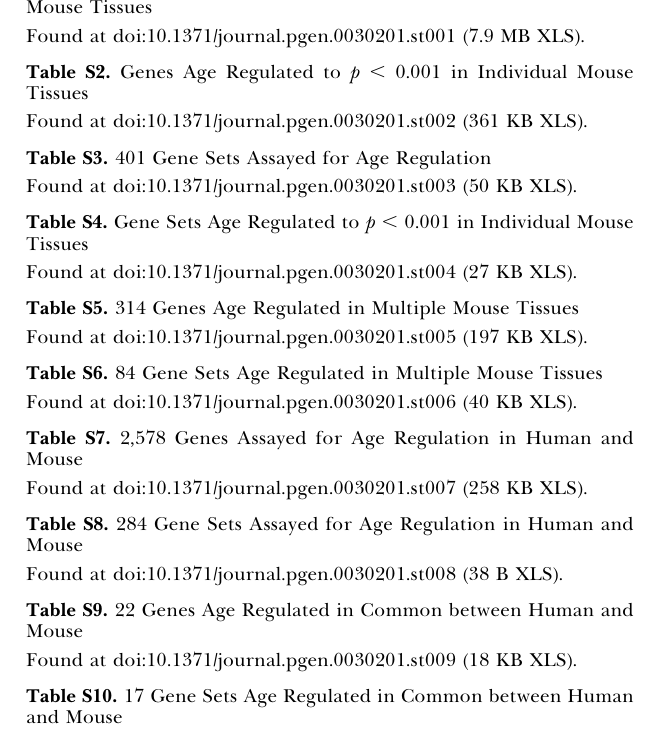
Figure S1. No Overall Correlation of Age-Regulated Expression Changes between Mouse and Human in Kidney and Muscle (A) Comparison of aging coefficients for 106 genes found to be age regulated in human kidney in both human and mouse. The x -axis shows the change in expression with age for each of 106 genes in the aging human kidney data (scale is expression per year). Similarly, the y -axis shows the change in expression with age for the same genes in the aging mouse kidney data (expression per month). (B) Comparison of aging coefficients for 22 genes found to be age regulated in human muscle. The x -axis refers to aging coefficients in human muscle, while the y -axis refers to aging coefficients in mouse muscle.